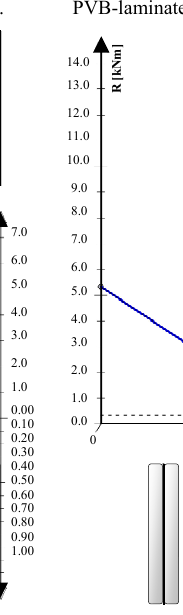
Figure 10: Element Safety Diagram for double layer, SG-laminated, heat strengthened glass